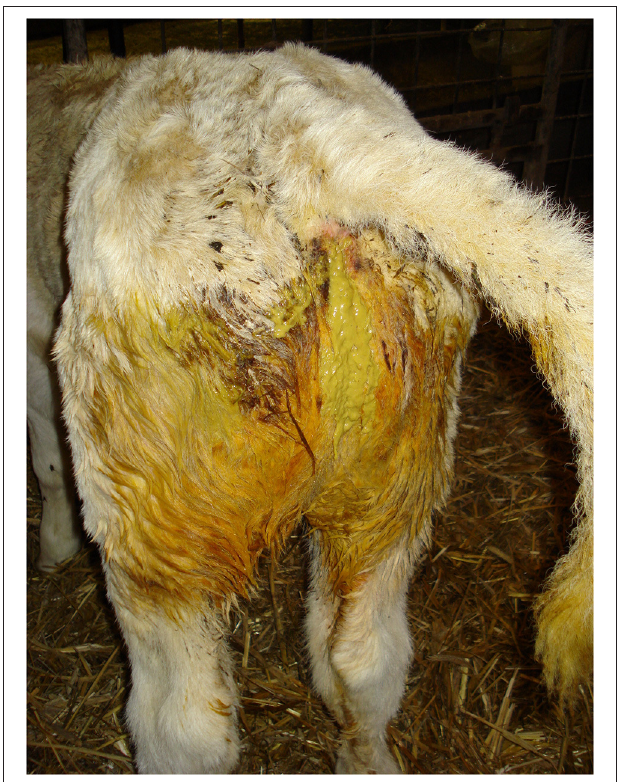
FIGURE 3 | Perineal fecal soiling in a calf with diarrhea.